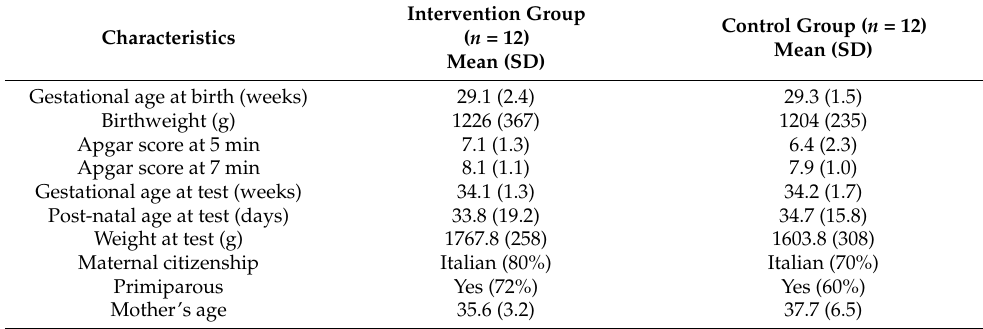
Table 1. Infants and mothers’ demographics.